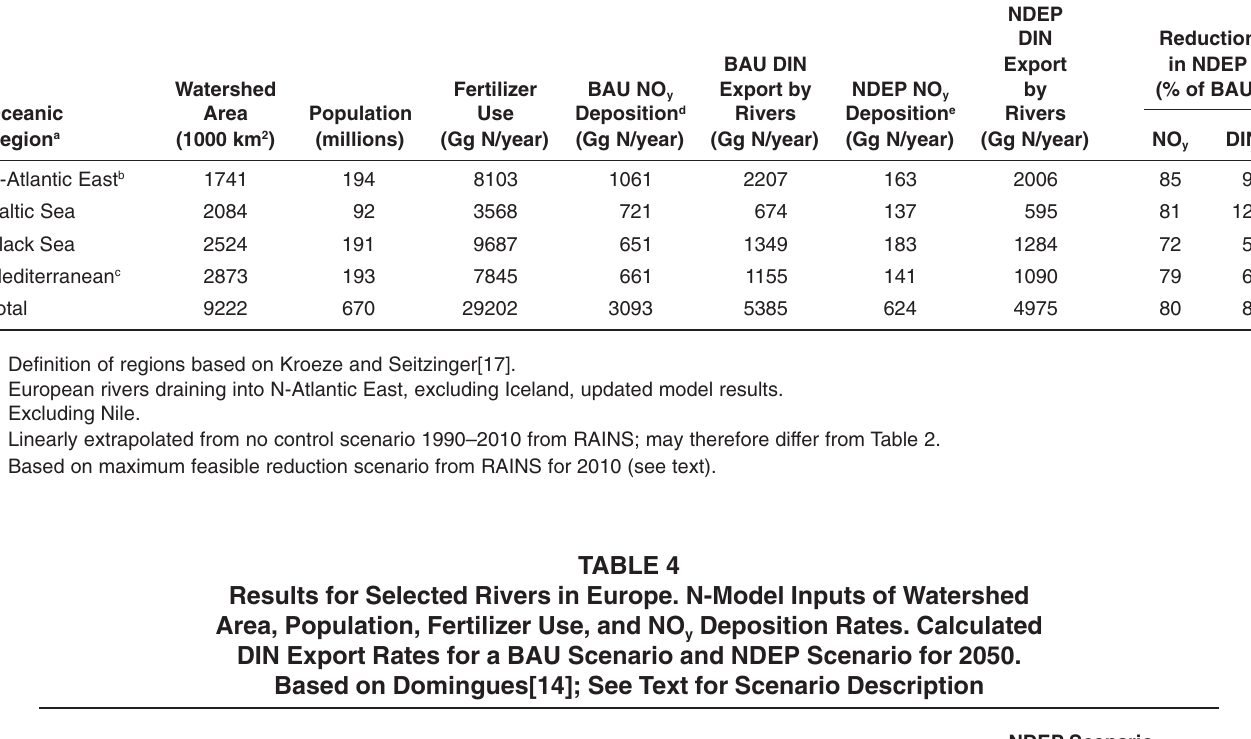
Deposition Rates) y